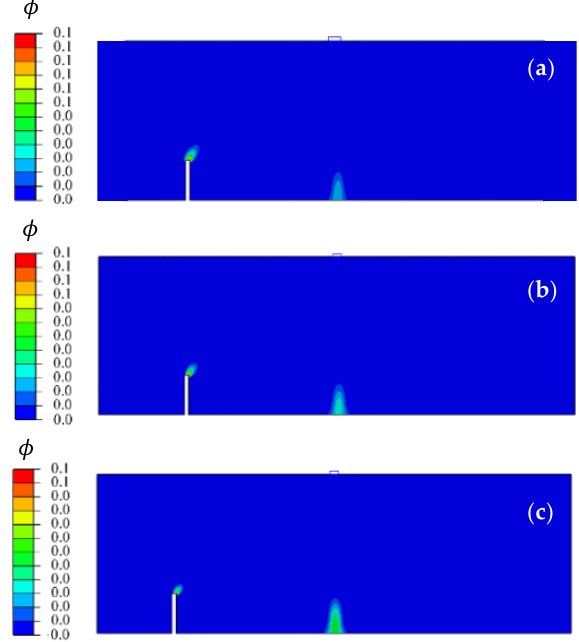
Figure 8. Damage profile when crack initiates at the mid-span for the first time: ( a ) γ = 0.70; ( b ) γ = 0.72; ( c ) γ = 0.77. (The phase field values are rounded to one decimal place).